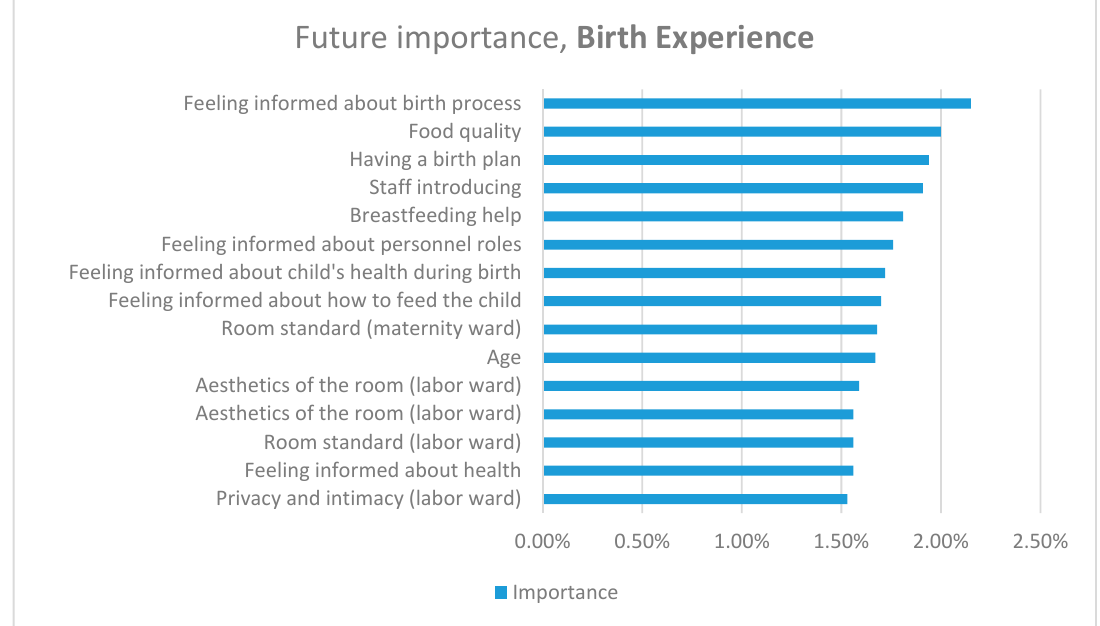
Figure 1. Most predictive variables for birth experience.